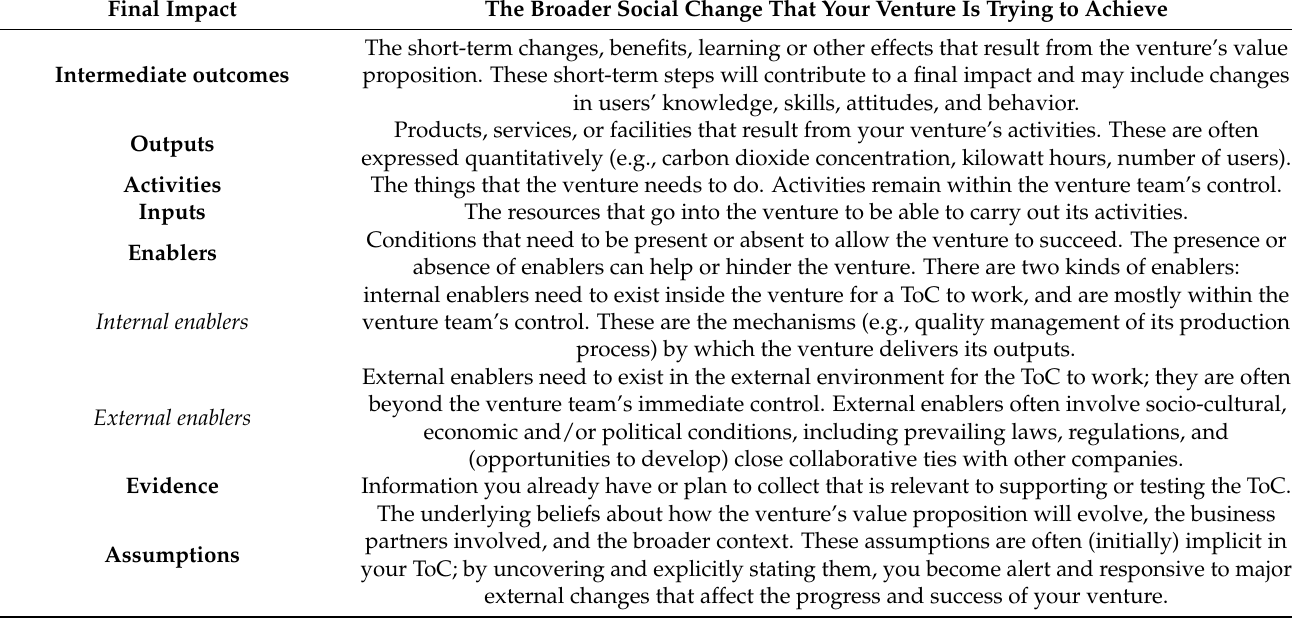
Table A1. Overview of Theory of Change (adapted from